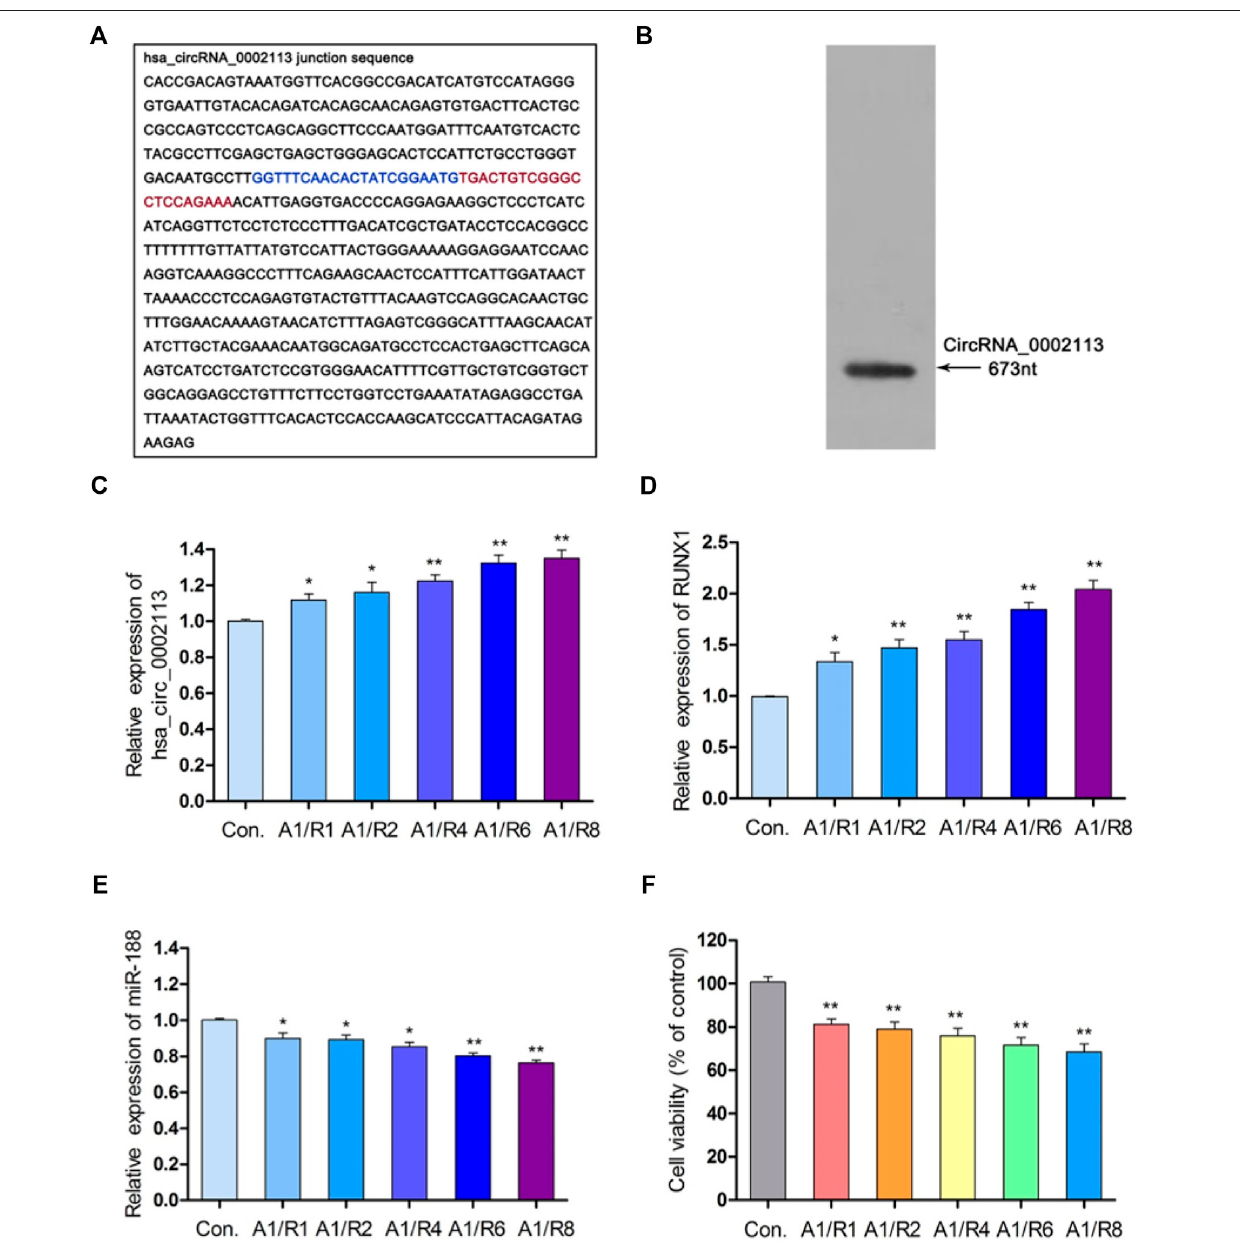
FIGURE1| CircRNA_0002113expressionwasinducedintheA/Rmodel. (A) ThesplicedsequencesofcircRNA_0002113.Thejunctionsitewaslocatedbetween the blue and red base. (B) CircRNA_0002113 sequence was validated by northern blotting. (C) The expression of circRNA_0002113 was evaluated after 1 h of anoxia followed by reoxygenation for 1, 2, 4, 6, 8 h. (D) The expression of miR-188-3p was evaluated after 1 h of anoxia followed by reoxygenation for 1, 2, 4, 6, 8 h. (E) The expressionofRUNX1wasevaluatedafter1 hofanoxiafollowedbyreoxygenationfor1,2,4,6,8 h (F) H9C2cellviabilitywasdeterminedafter1 hofanoxiafollowed by 1, 2, 4, 6, 8 h of reoxygenation. * p < 0.05, ** p < 0.01, compared with the control. A, anoxia; R, reoxygenation.